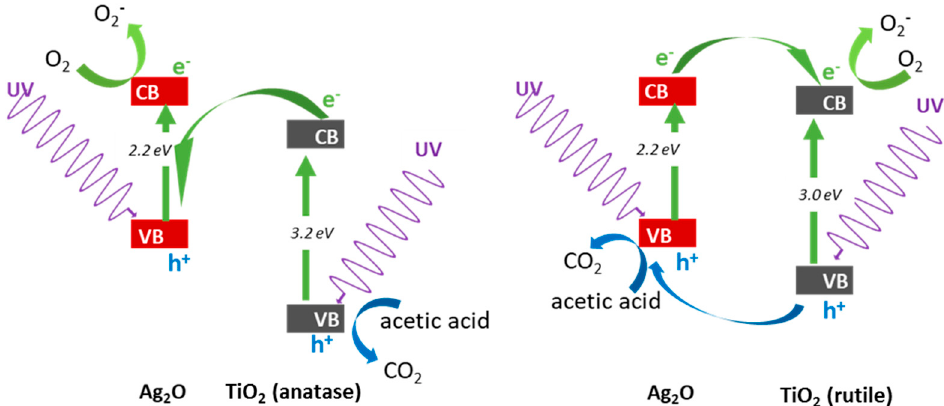
Figure 8. The schematic mechanisms of oxidative decomposition of acetic acid under UV/vis irradiation with Ag 2 O/TiO 2 photocatalysts: Z-scheme for anatase ( a ) and heterojunction (type II) for rutile ( b ).